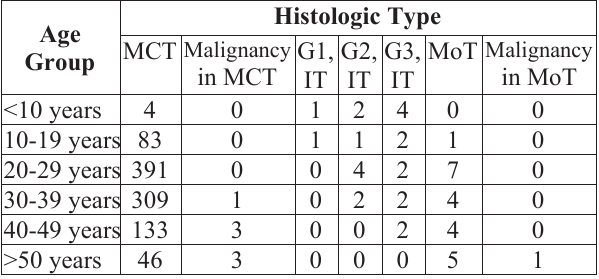
Table-3: Frequency of different histologic subtypes and